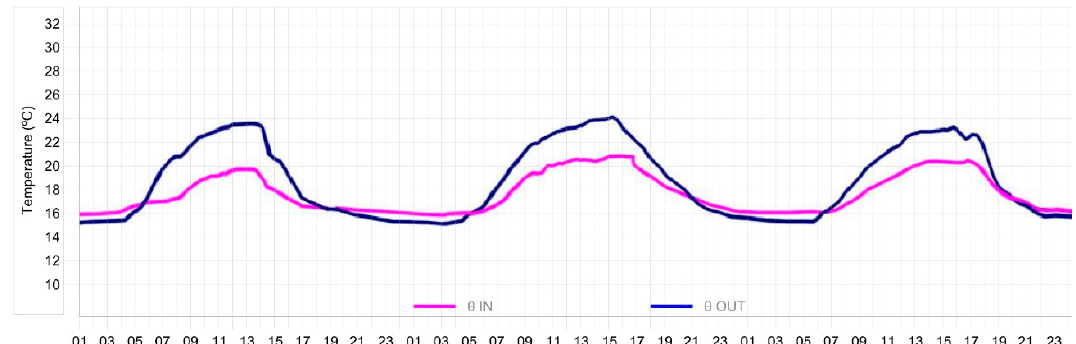
Figure 6. Measured data of the inlet and outlet temperature of the WFG cabin. Sample summer days: 23/08/2010, 24/08/2010, and 25/08/2010.